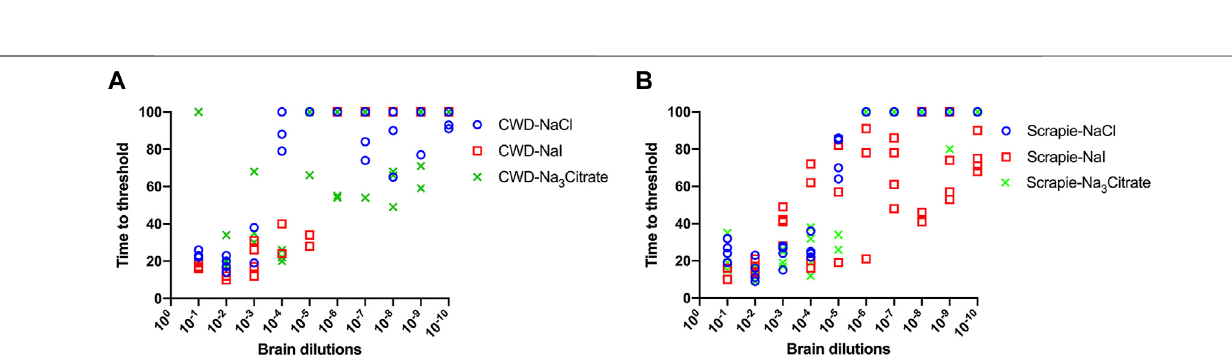
FIGURE 6 | Representative Hofmeister ion effects on RT-QuIC reactions seeded with scrapie-positive sheep brains using BV rPrP substrate. RT-QuIC reactions were seeded with 10 − 1 , 10 − 2 , 10 − 3 , 10 − 4, 10 − 5 , 10 − 6 , 10 − 7 , 10 − 8 , 10 − 9 , and 10 − 10 dilutions of the brain homogenate from one CWD-positive deer (A) and one scrapie- positive sheep (B) with the addition of 0.001% of SDS. Substrate contained BV rPrP and 400 mM NaCl, NaI, or Na 3 citrate. Reactions were run at 42 °